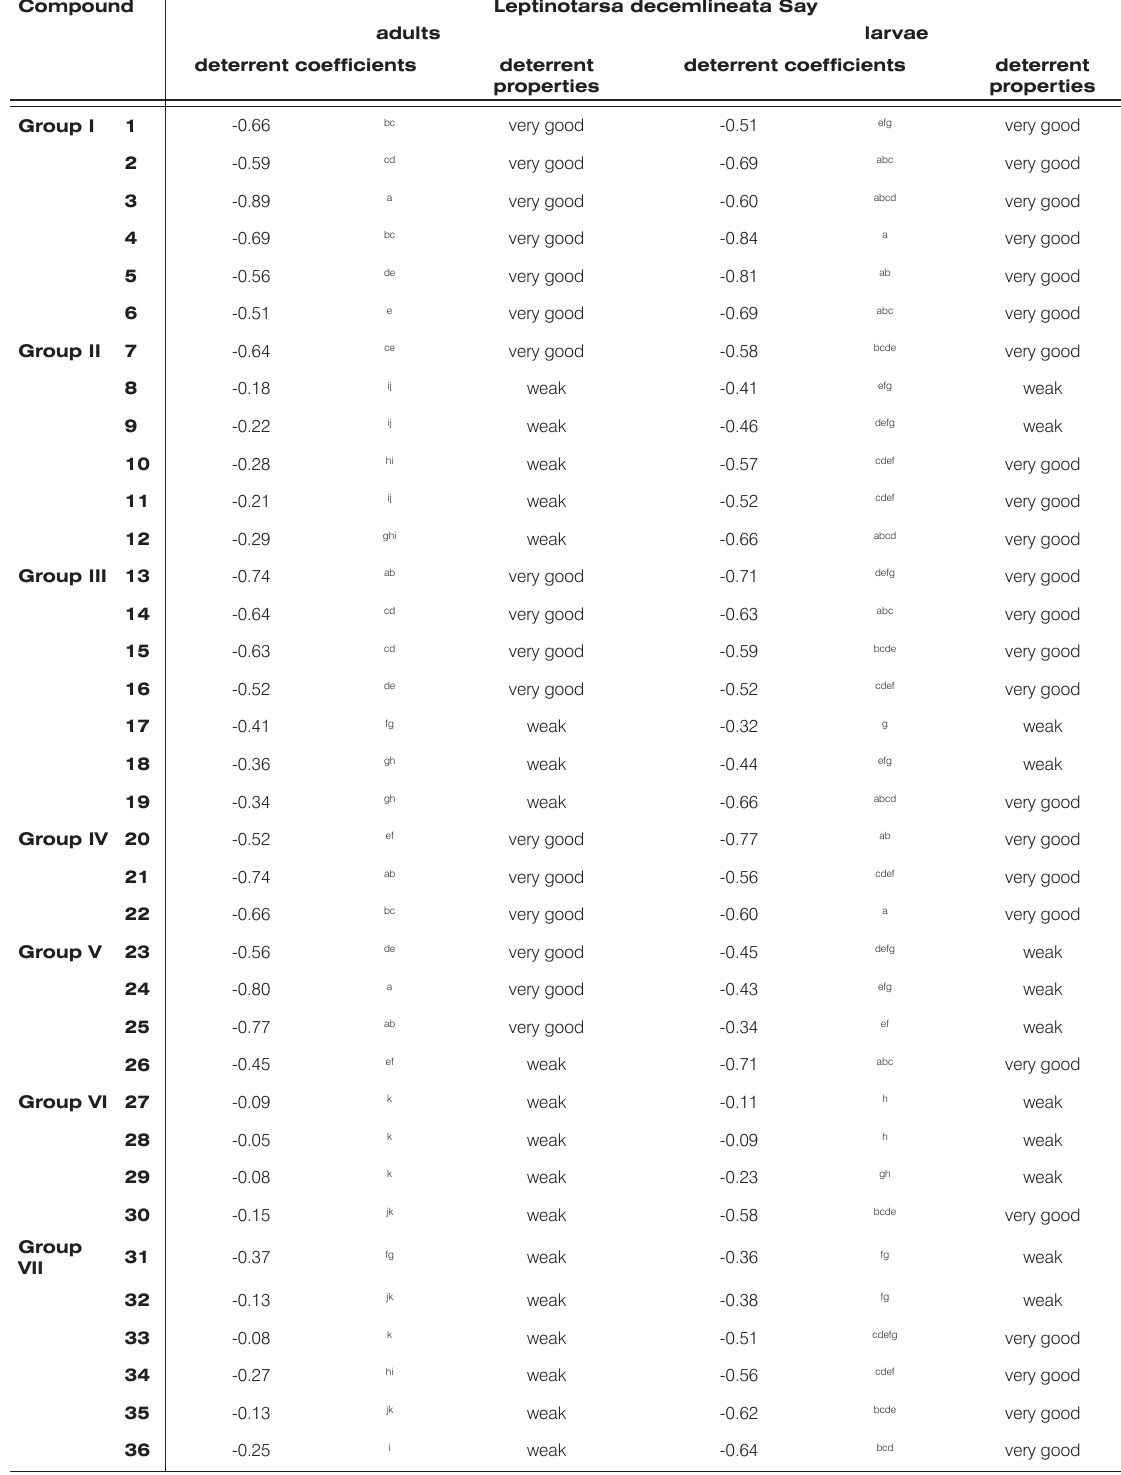
Table 4. Feeding deterrent activity of compounds studied against the Colorado potato beetle. Compound Leptinotarsa decemlineata Say adults larvae deterrent